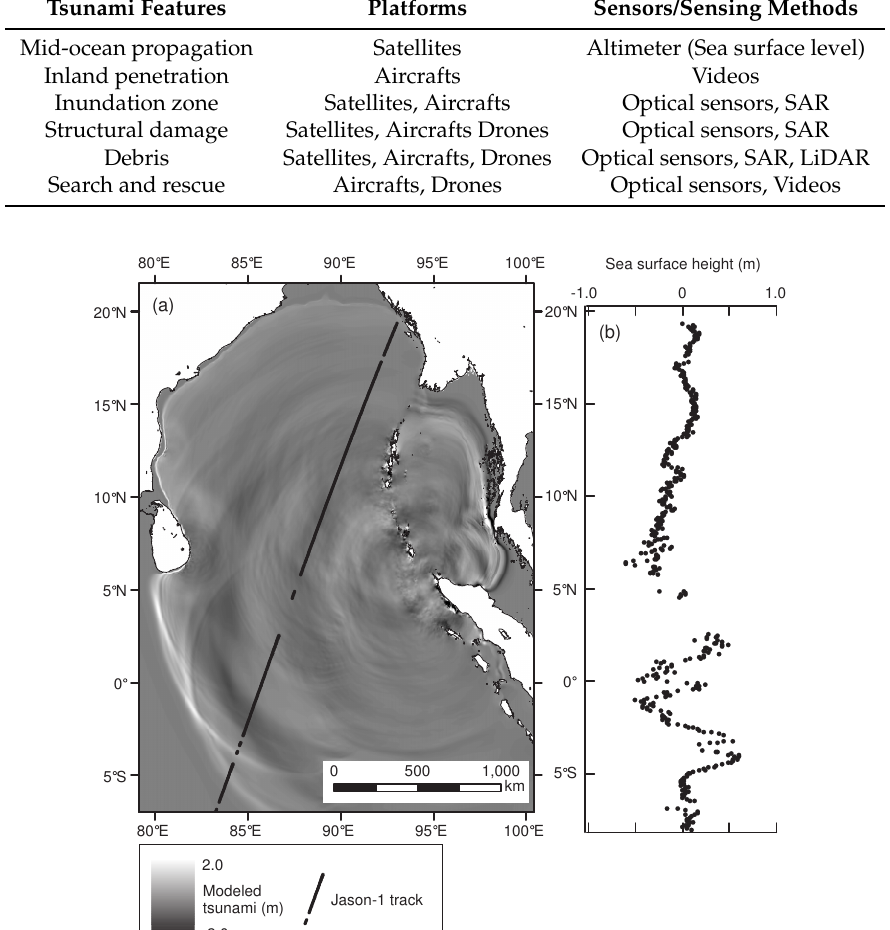
Figure 1. ( a ) The track of the satellite Jason–1 mission on 26 December 2004 with the modeled tsunami propagating at 2 h after the Sumatra–Andaman earthquake [9]. Note that Jason–1 spent approximately 8.3 minutes to fly over the track from 5 ◦ S to 20 ◦ N. ( b ) The extracted tsunami height along the track